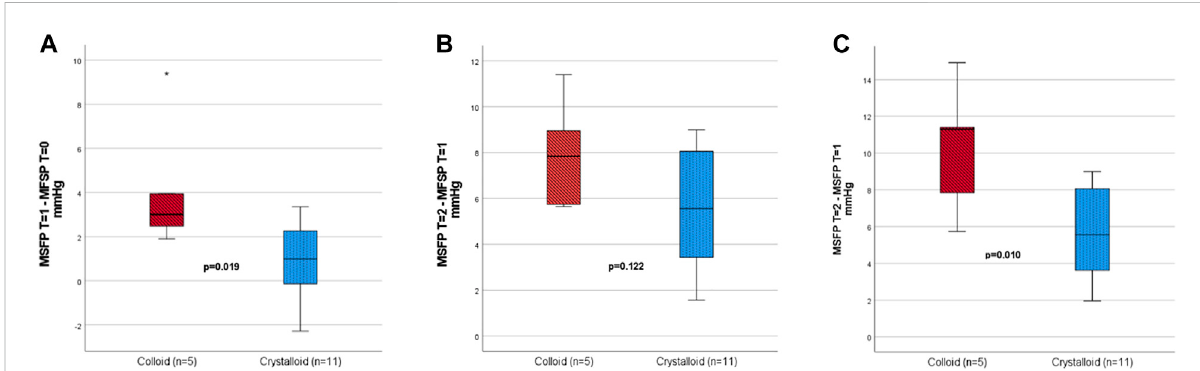
FIGURE 2 (A) Delta fi rst fl uidbolus,100 ml; (B) deltasecond fl uidbolusplannedtobe500 ml,butin40%ofthecolloidgroupthe fl uidinfusionwasceased prematurely;and (C) posthocanalysisforahypotheticaldeltaMSFPifthetotalof500 mlwouldhavebeenadministered.MSFP,meansystemic fi lling pressure. mmHg: millimetres of mercury. The thin vertical black stripe represents the minimum and maximum MSFP. The boxplot represents 25th – 75th quartile. The horizontal thick black stripe represents median. p values for the independent t -test ( fi rst). Red and slash to the right = colloid. Blue and dots =